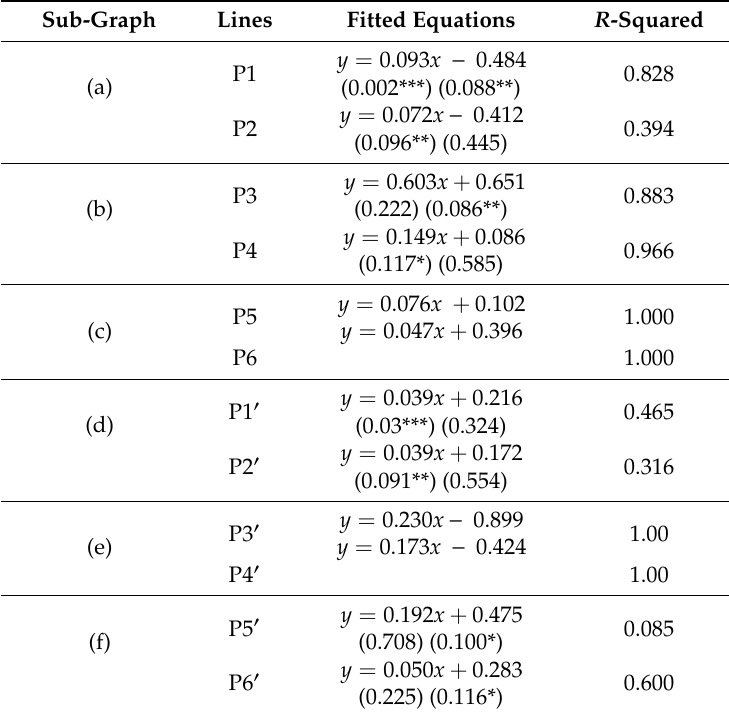
Table A2. Fitted equations and parameters for the curves in Figure